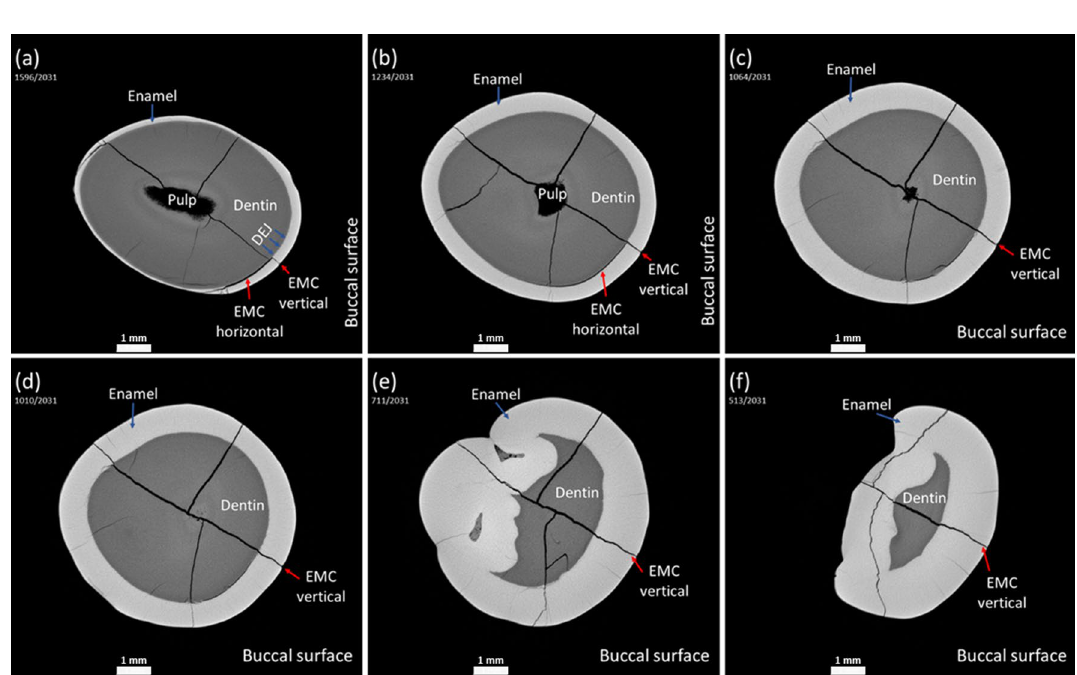
Figure 7. The path of the longest EMC visible on the outer buccal surface as it extends from ( a , b ) the cervical ( c , d ) to the middle and ( e , f ) occlusal parts of the tooth crown. Anatomical tooth structures (pulp, dentin, DEJ, enamel, EMC) are